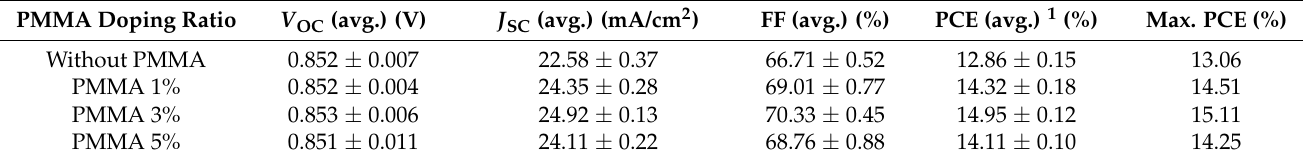
Table 1. Photovoltaic performance parameters of OSCs with pristine NiO x HTLs and NiO x :PMMA HTLs with different PMMA doping ratios.